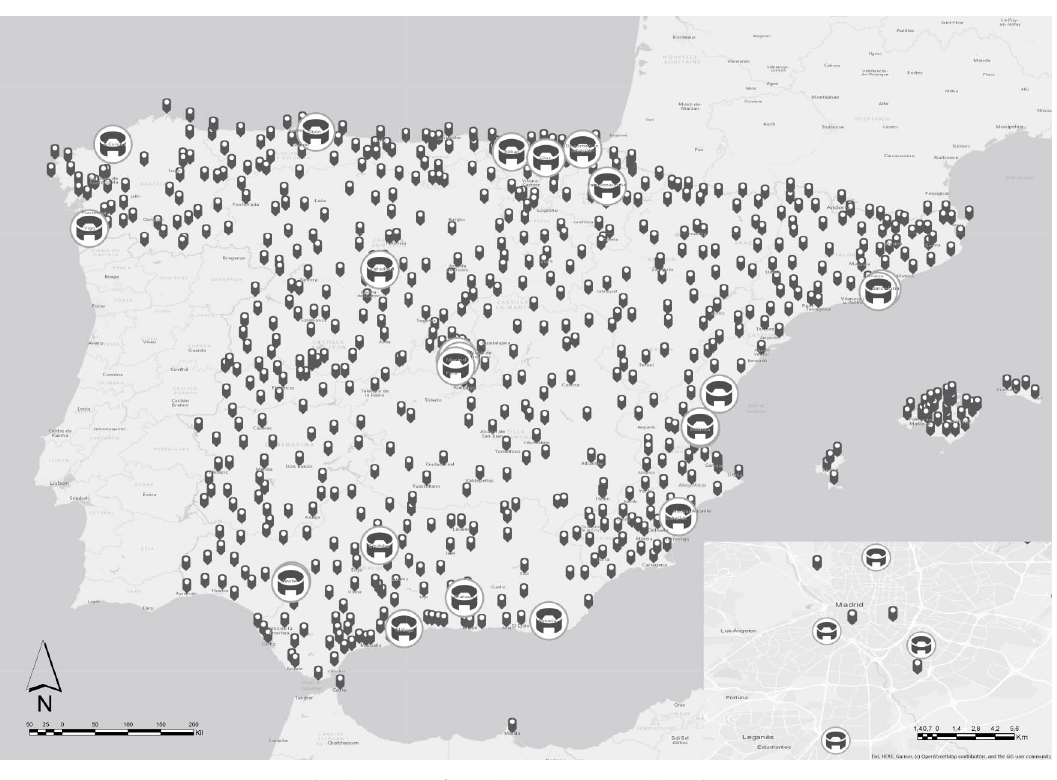
Figure 2. The location of weather stations and stadiums in